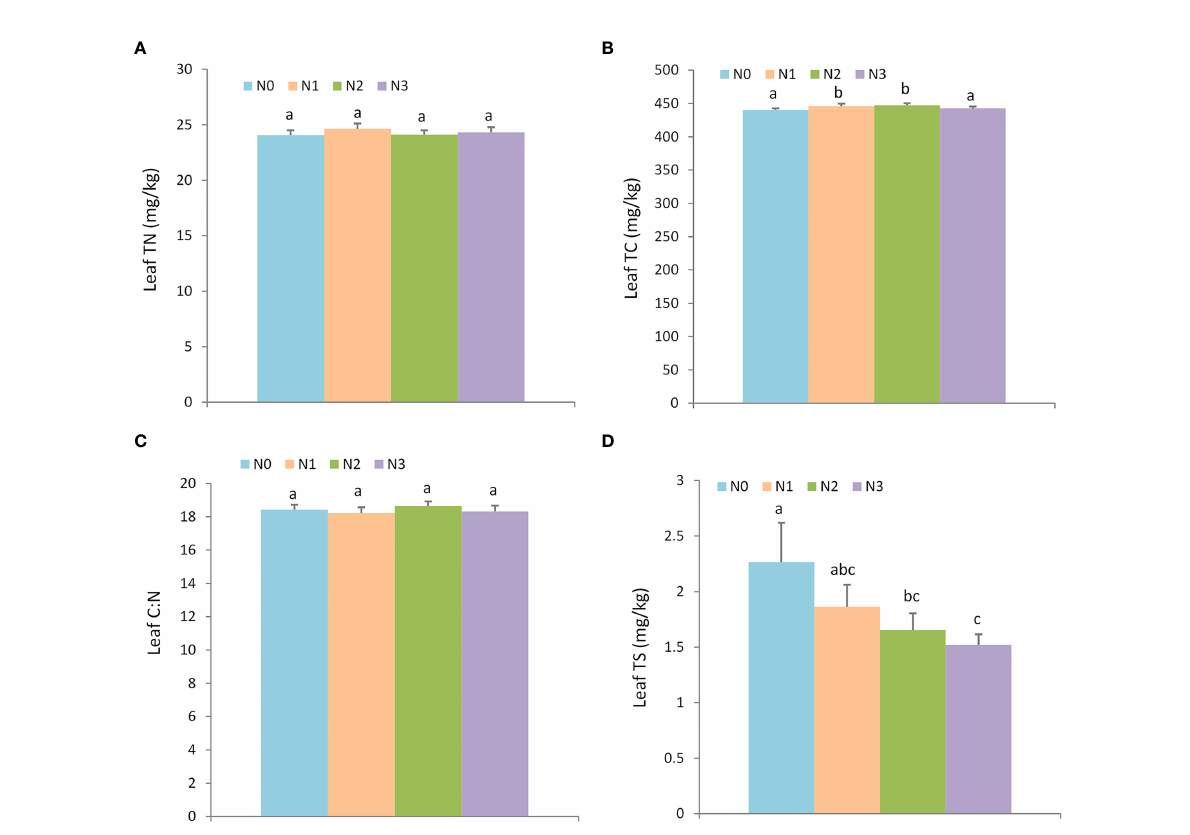
FIGURE 3 The effect of nitrogen addition on plant nutrients. Different letters denote statistically signi fi cant differences. N0: 0 g (cid:129) m -2 (cid:129) year -1 ; N1: 5 g (cid:129) m -2 (cid:129) year -1 ; N2: 20 g (cid:129) m -2 (cid:129) year -1 ; N3: 50 g (cid:129) m -2 (cid:129) year -1 . A : Leaf TN (mg/kg); B : Leaf TC (mg/kg); C : Leaf C:N; D : Leaf TS